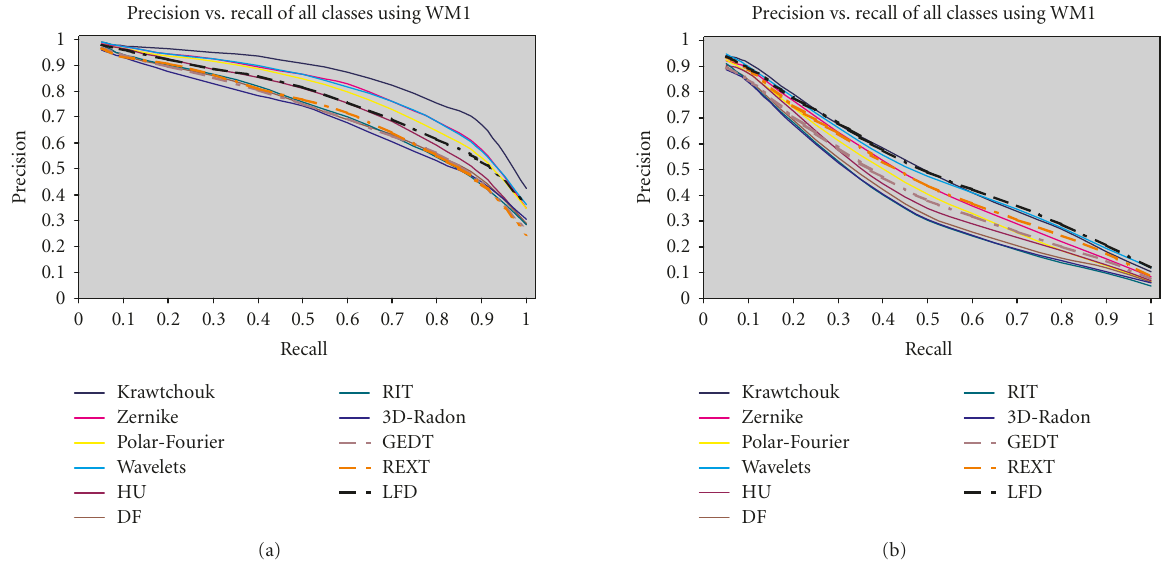
Figure 7: Precision-recall curves diagram using the weight method 1 for the new database (a) and for the Princeton database (b).